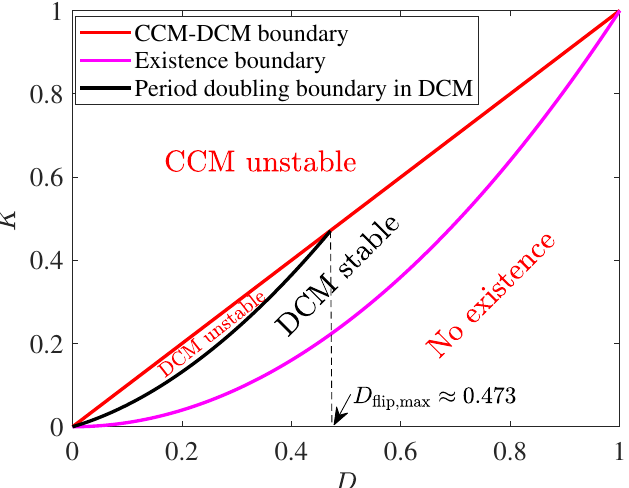
Figure 14. Regions of the dynamical behaviors of the open-loop-DCM-operated boost converter with a CPL in the plane ( D , K ) and the parameter values shown in Table